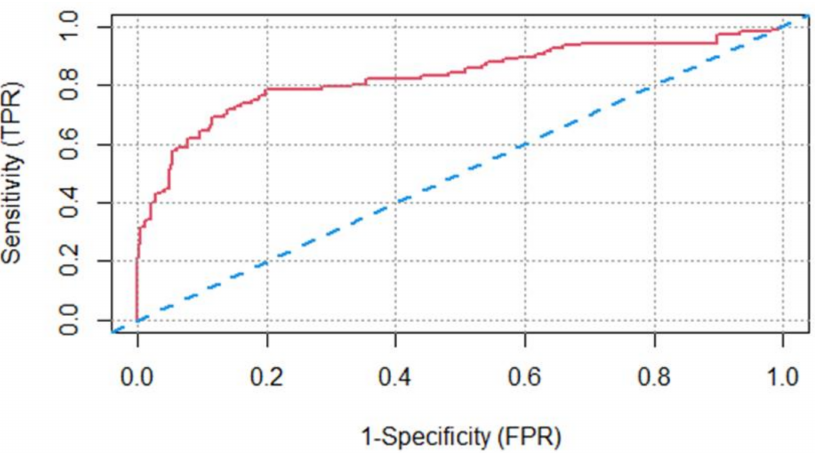
Figure 5. Receiver operating characteristic curve (ROC) of CD24 blood test. The top curve uses a CD24 score cutoff (AUC = 0.83). The bottom curve is what would be expected by chance alone (AUC =